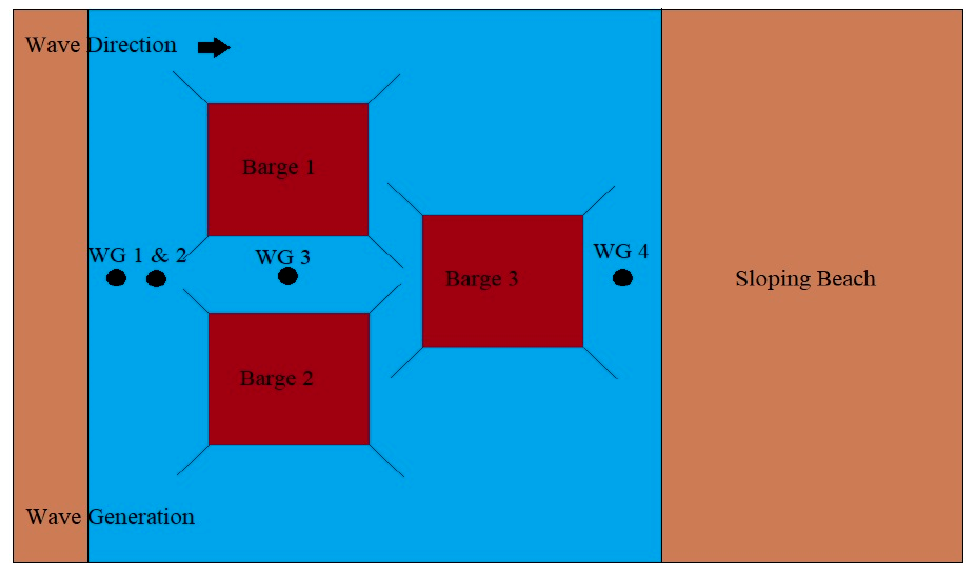
Figure 11. Schematic diagram of the experimental setup in a shallow wave basin in plain view.